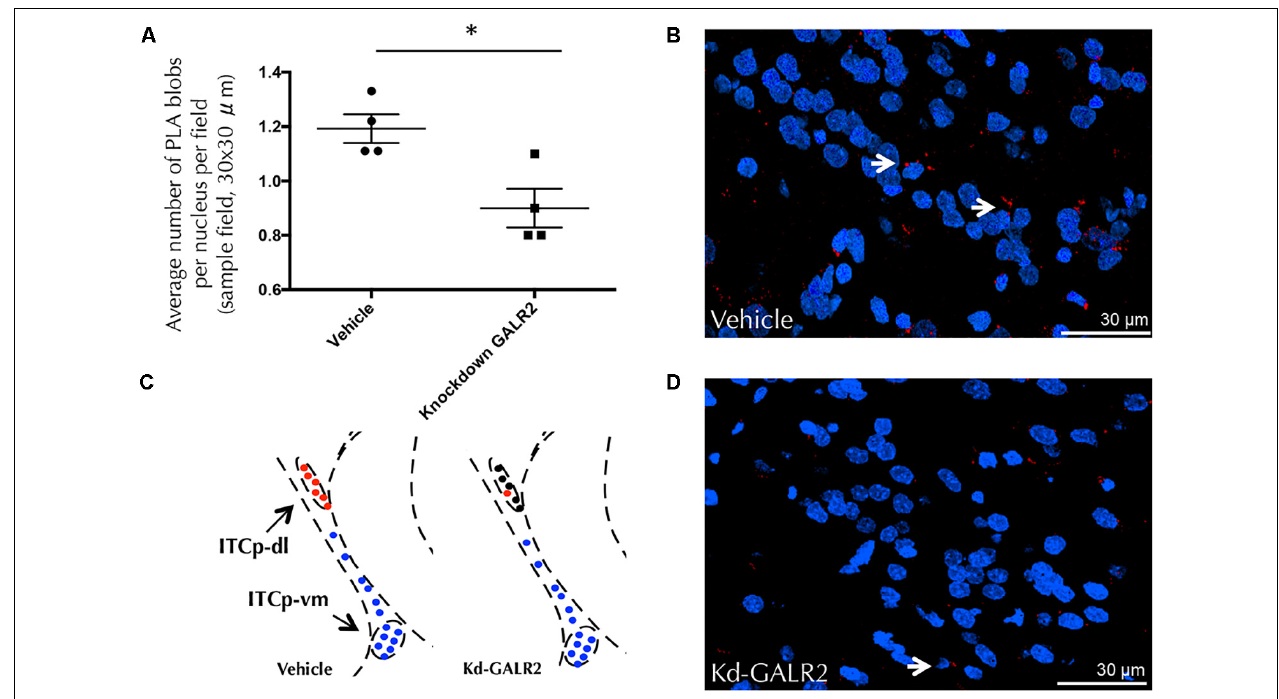
FIGURE 8 | GALR2/NPYY1R heteroreceptor complexes are modified in the dorsolateral cluster of the medial paracapsular intercalated nucleus of the amygdala (ITCp-dl) by using in situ PLA after knockdown of GALR2 in rats. No differences were observed with siRNA Control rats (Accell Non-targeting pool) (Millon et al., 2015; Flores-Burgess et al., 2017). Therefore, vehicle group (Accell siRNA Delivery Media) was used as control. (A) Quantification of PLA signals as blobs per nucleus per sampled field by an experimenter blind to treatment conditions. Knockdown GALR2 rats showed a significant decrease in GALR2/NPYY1R heteroreceptor complexes (PLA blobs) in the ITCp-dl cluster. ∗ P < 0.05 knockdown (Kd) GALR2 versus vehicle rats according to Student’s t -test. Data are expressed as mean ± SEM, Each point in the graph represents results from multiple photographs analyzed and taken from individual rats ( N = 4 rats per group). (B) Diagram shows positive PLA signals (red circles) in the ITCp-dl in control animals and loss of specific signals (black circles) in the ITCp-dl in knockdown GALR2 rats. Blue circles indicate lack of specific signals in the ventromedial cluster (ITCp-vm). [Bregma: –2.3 mm; according to the Paxinos and Watson (1986) stereotaxical atlas]. (C,D) Representative microphotograph of the decreased density of GALR2/NPYY1R positive red PLA blobs observed in the GALR2 Knockdown animals (D) compared with control rats (C) . GALR2/NPYY1R heteroreceptor complexes are shown as red PLA blobs (clusters) using confocal laser microscopy, White arrows point to red PLA clusters. The nuclei are shown in blue by DAPI. Abbreviations: Control, Rats injected icv with Accell siRNA Delivery Media; Kd-GALR2, Rats injected icv with Accell siRNA